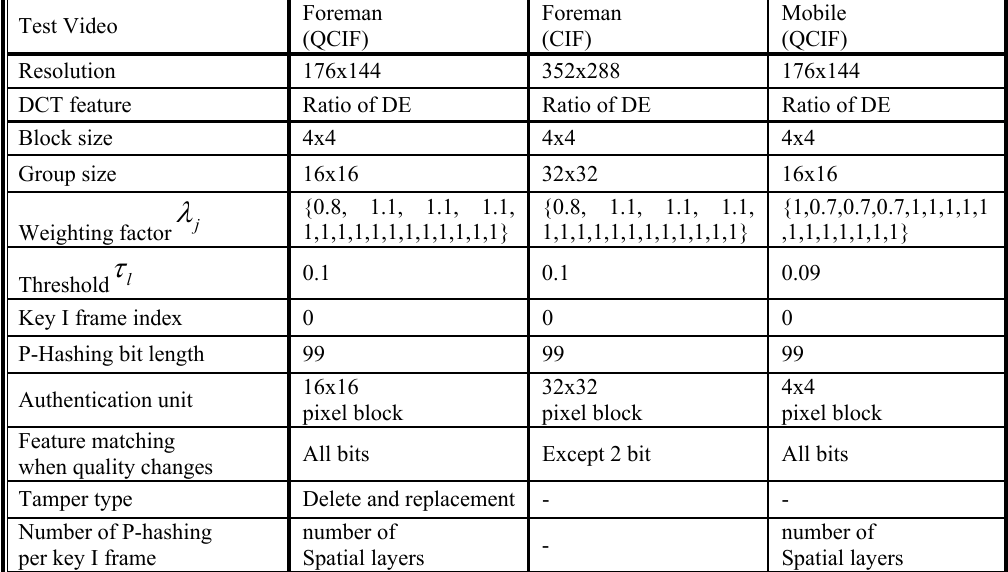
Table 1. Experiment parameters for authentication scheme